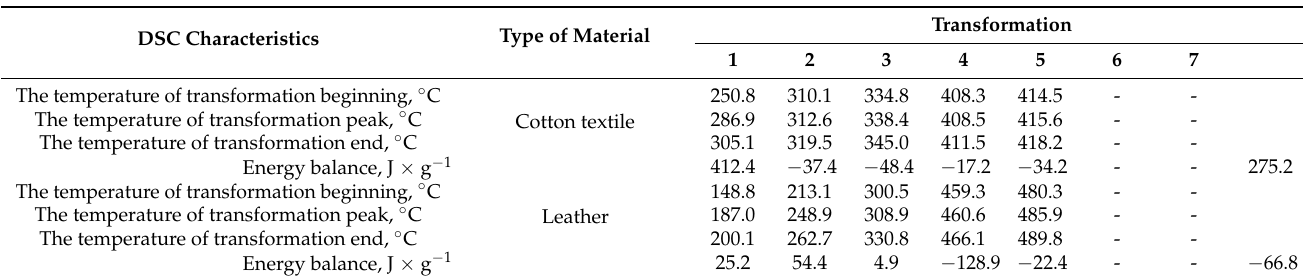
Table 5. Normalized transformation energy for successive transformations of tested textile waste and energy balance of the process. DSC